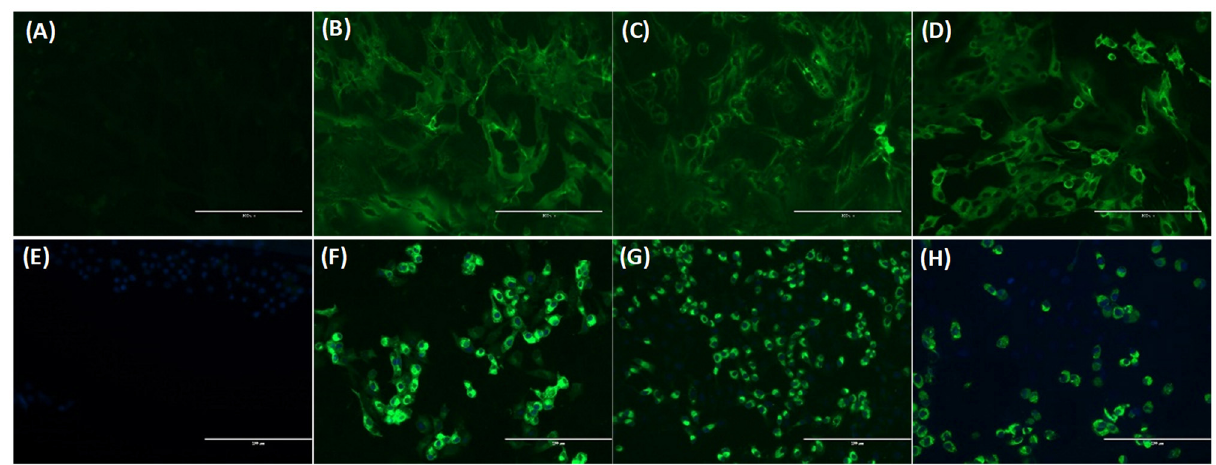
FIGURE 5 | Immunofluorescence assay (IFA) analysis of Crandell feline kidney (CrFK) and Vero E6 cells infected with FeCoV virus (A–D) and SARS-CoV-2 (E–H) , respectively. Results of FeCoV IFA (A–D) with negative control cat serum (A) , FeCoV-positive cat serum #1 from Table 6 (B) , SARS-CoV-2-specific antibody-positive cat serum #328 from Table 7 (C) , and FeCoV N protein-specific monoclonal antibody (D) . IFA for SARS-CoV-2 (E–H) with FeCoV antibody-negative cat serum #12 from Table 6 (E) , SARS-CoV-2 antibody-positive cat serum #026 from Table 7 (F) , FeCoV antibody-positive serum #1 from Table 6 (G) , and SARS-CoV-2 RBD protein-specific monoclonal antibody #117A5 from Table 7 (H) . The photographs were taken using a fluorescence microscope for both IFAs with a serum dilution of